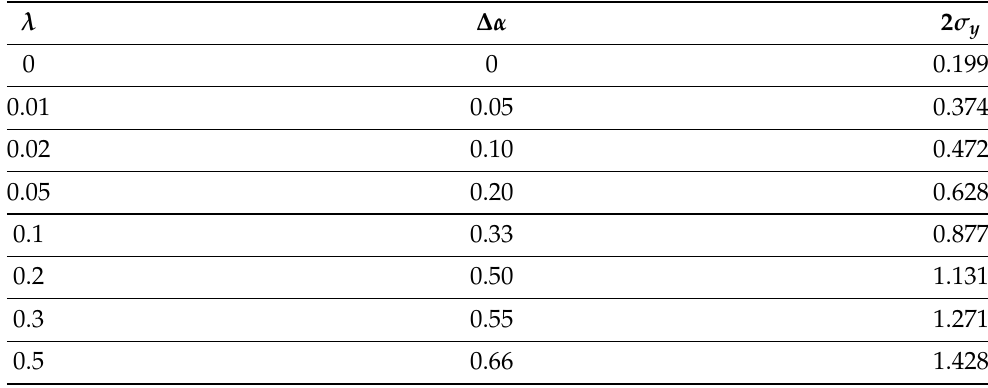
Table 1. Simulation results of Example 1.